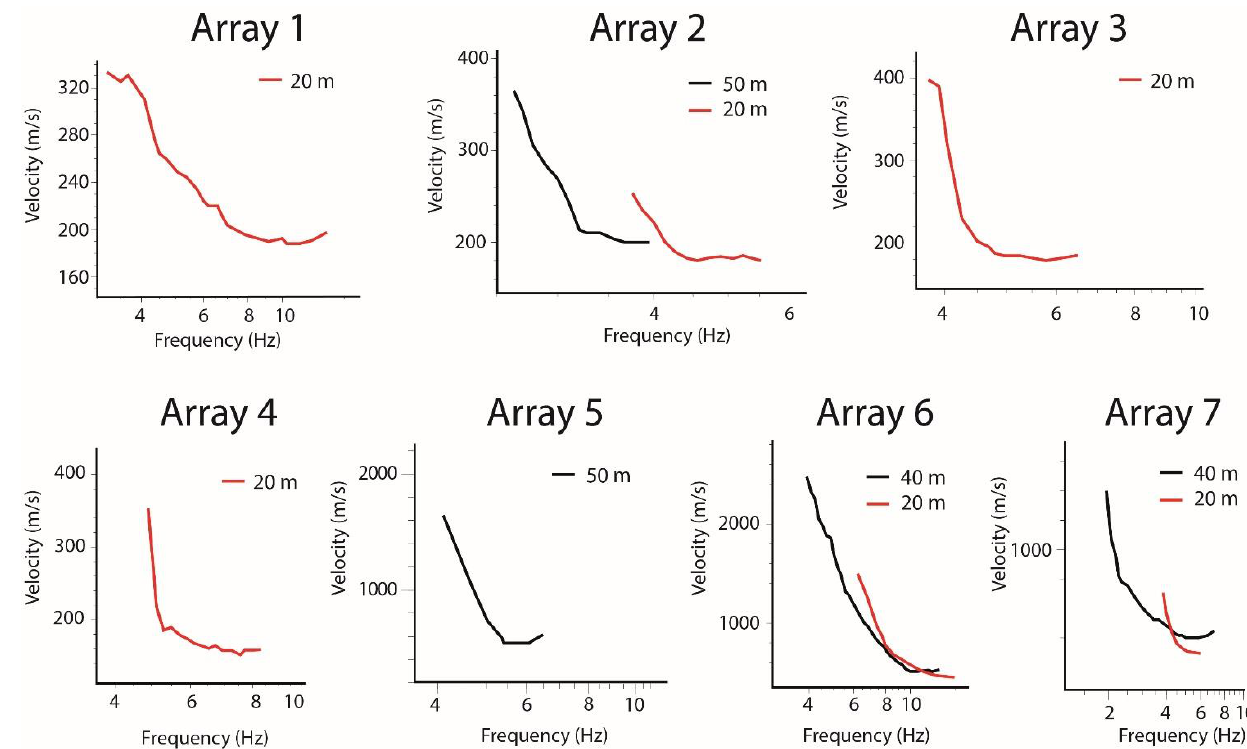
Figure 10. Surface wave dispersion curves.